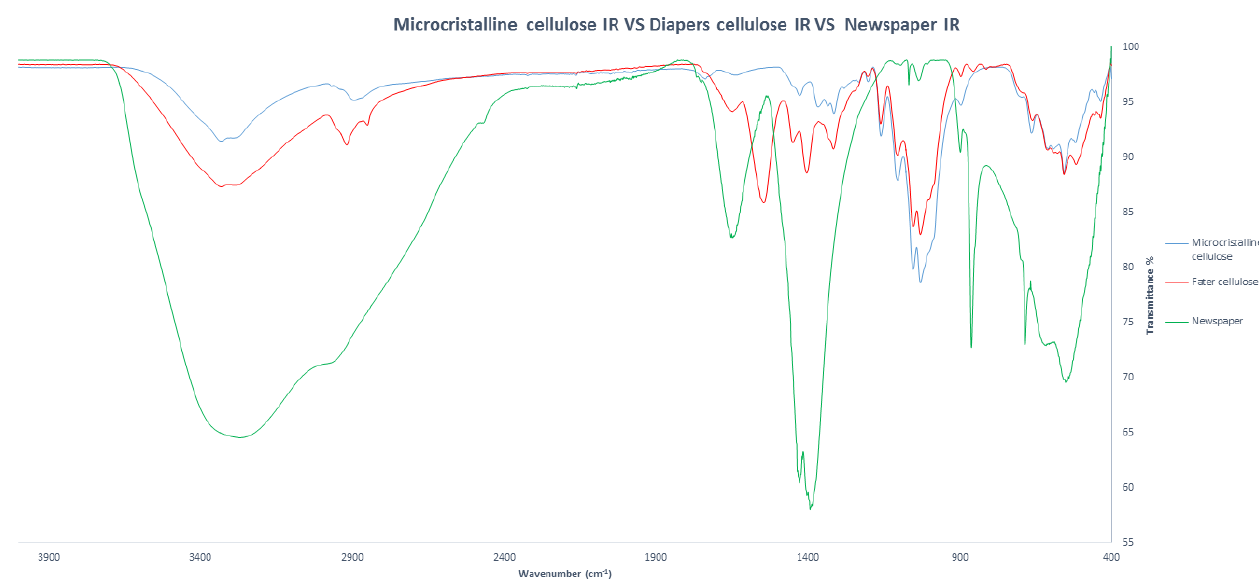
Figure 1. FTIR-ATR of the cellulose acetate (orange line) and cigarette butts (blue line).